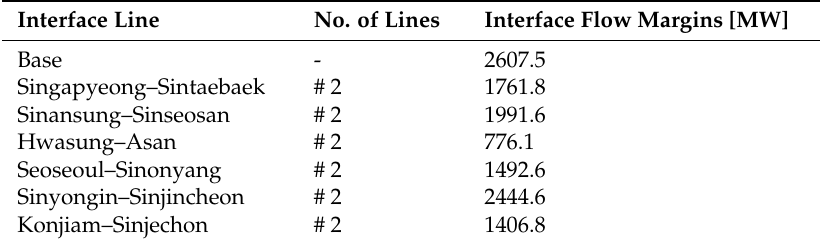
Table 5. Interface flow margin of interface line.